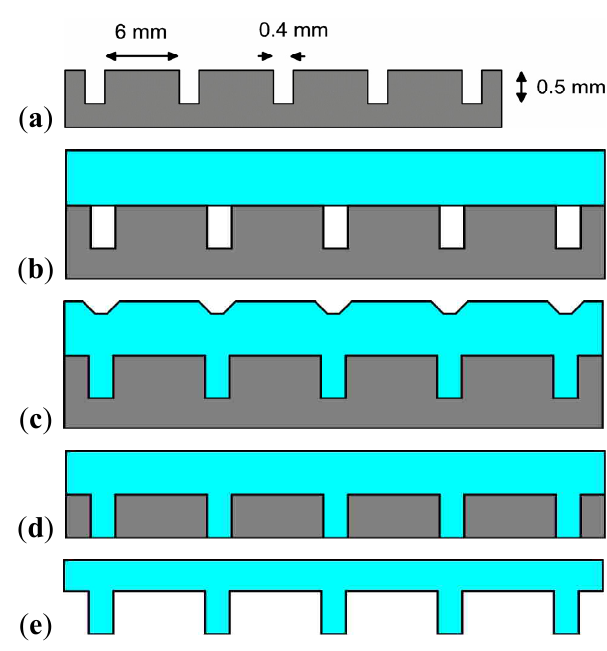
Figure 5. Fabrication of glass cap wafers.